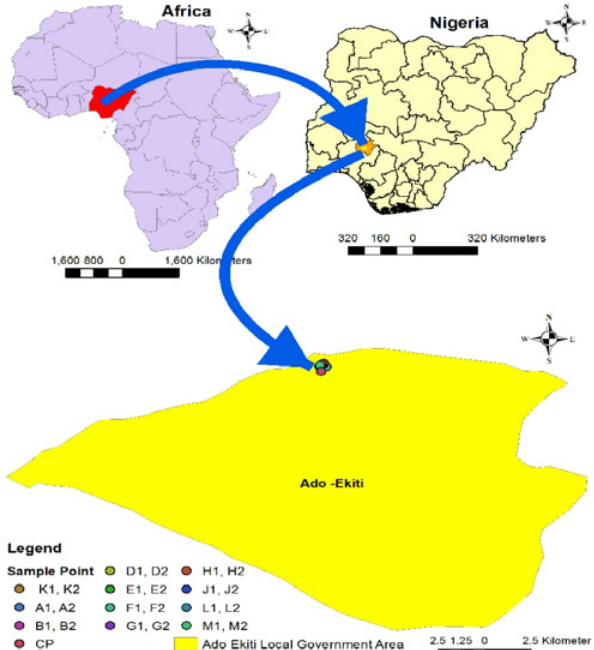
Fig. 1: Geographic location of the study area along with the sampling points in Ado Ekiti, Nigeria